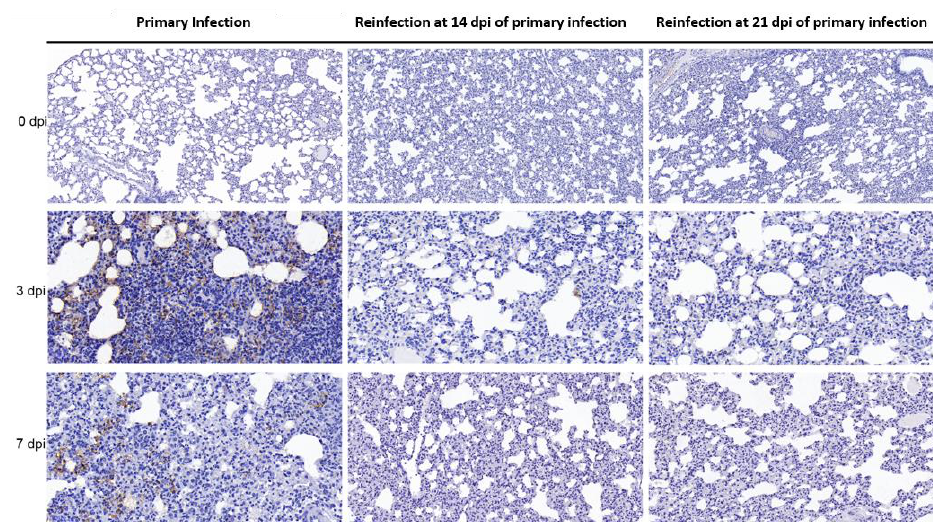
Figure 5. Little viral load was present in the lung in the reinfection, while high levels of SARS-CoV-2 were observed in the primary infection. The distribution and viral load of SARS-CoV-2 in the lung were detected by SARS-CoV-2-N protein-IHC, and the lungs were detected at 0 dpi, 3 dpi, and 7 dpi in the primary and secondary infection groups.